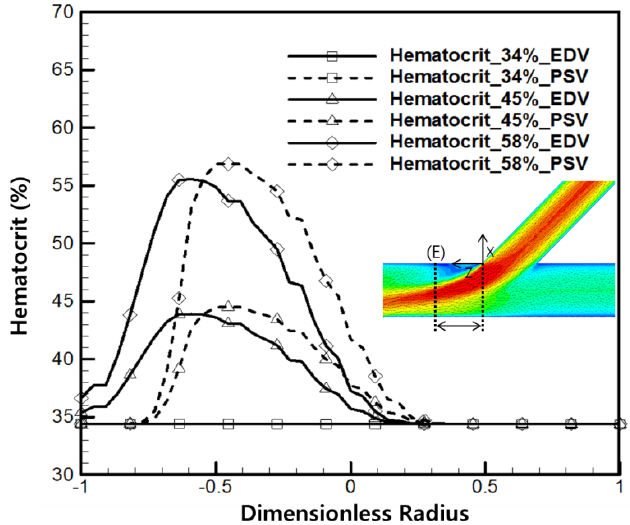
Figure 6. Hematocrit distribution at Line (E), anastomosis angle is 45 ◦ , the hematocrit is concentrated in a parabolic shape under the influence of flow from the graft.